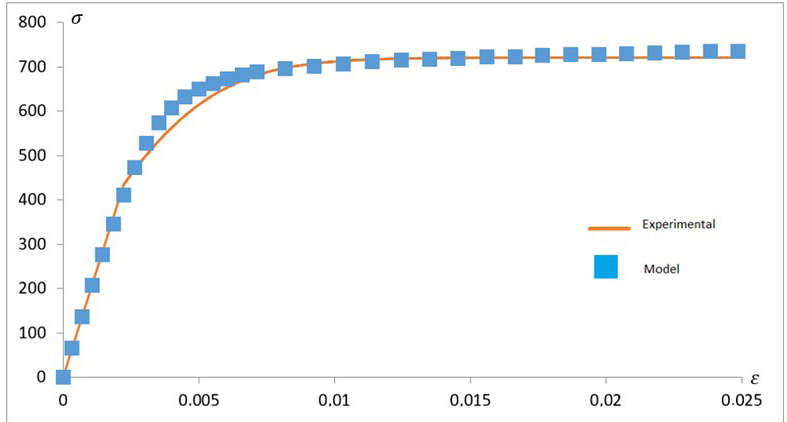
Figure 13. Comparative stress curve (MPa) - strain (mm / mm) -